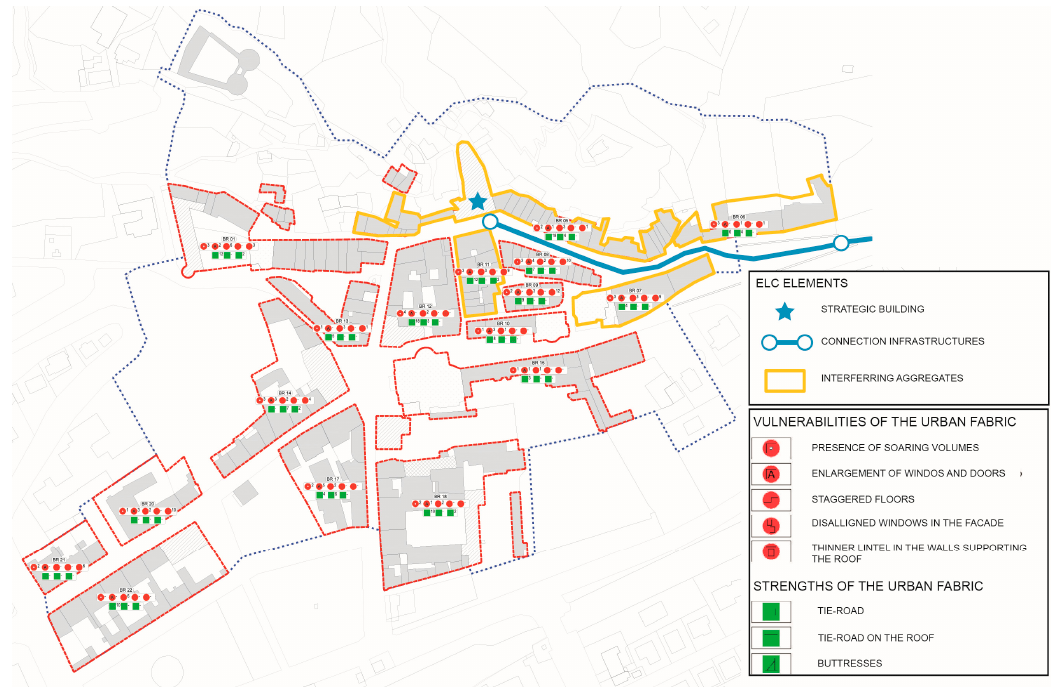
Figure 1. The Emergency Limit Condition of the historic Centre of Brisighella.